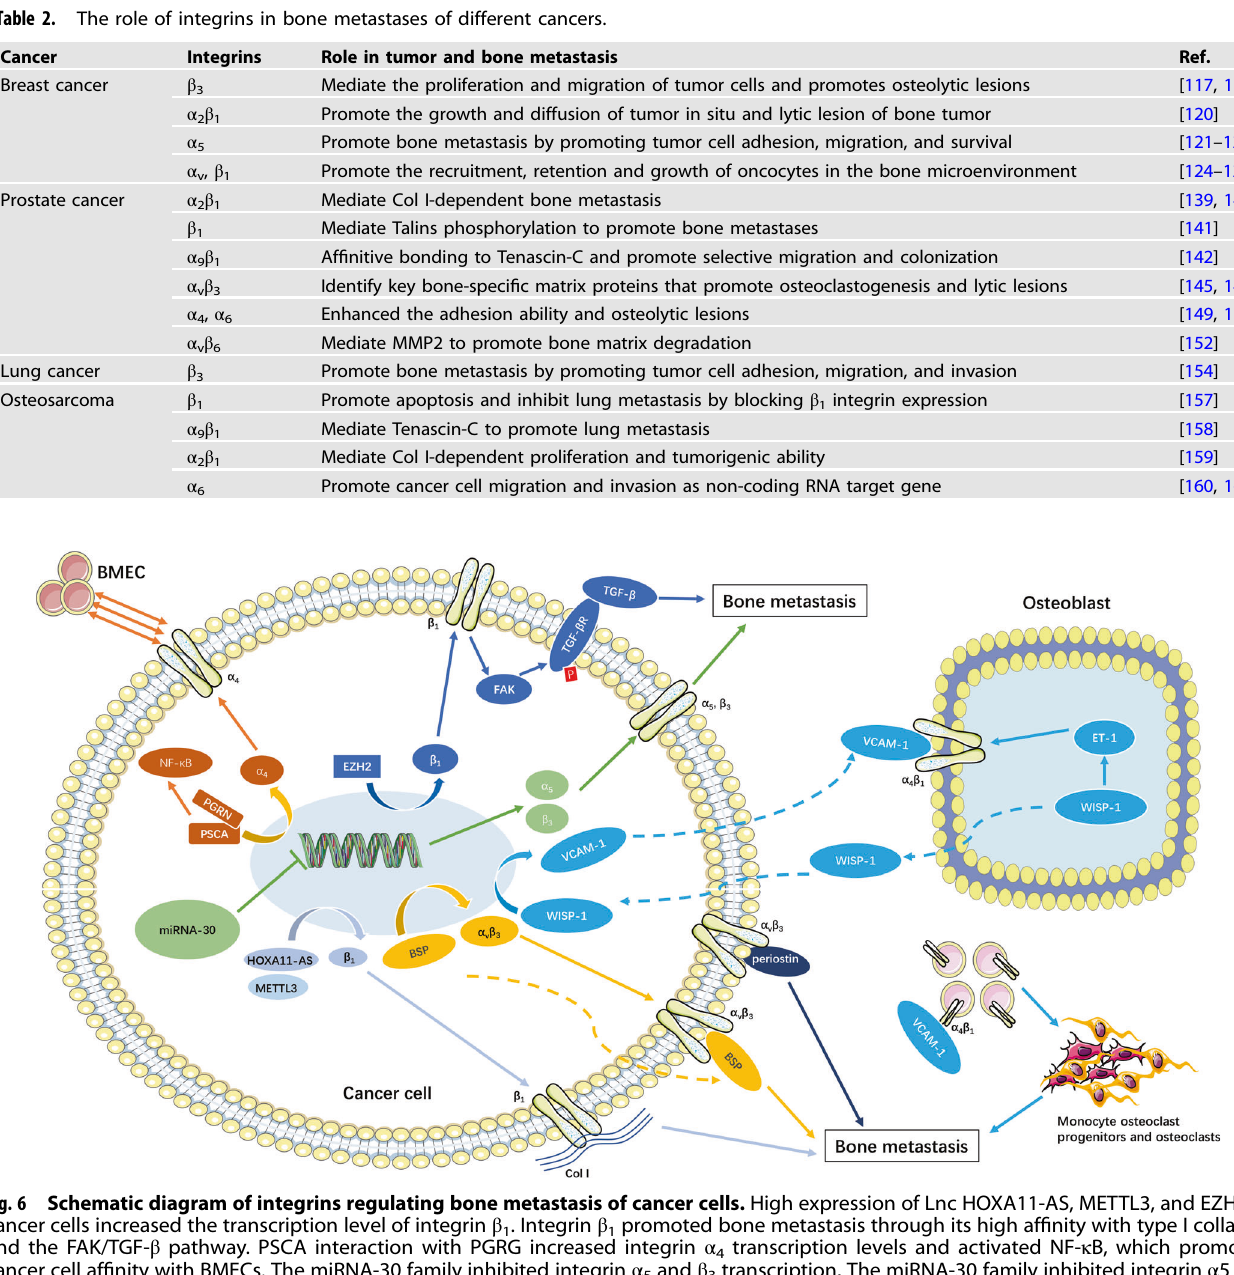
β v 3 expression